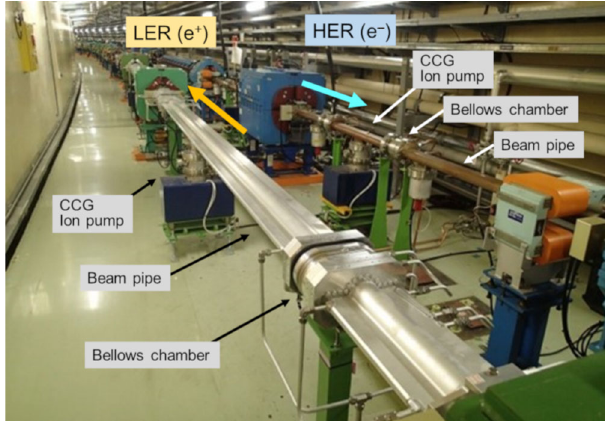
FIG. 3. Layout of the beam pipes, bellows chambers, ion pumps, and CCGs for LER and HER in the MR